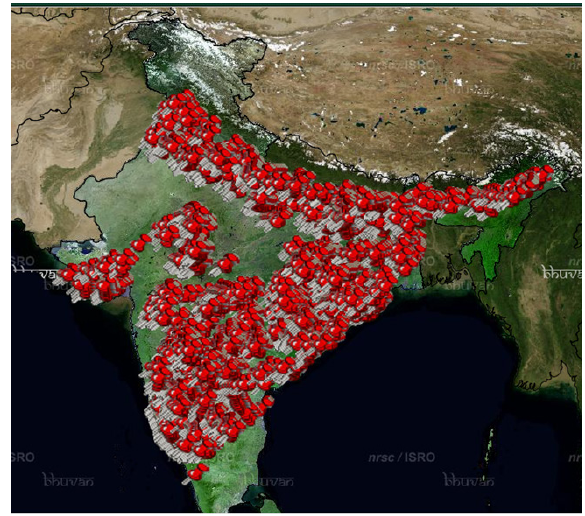
Figure 3. Overview of Ground truth points for Haryana state,